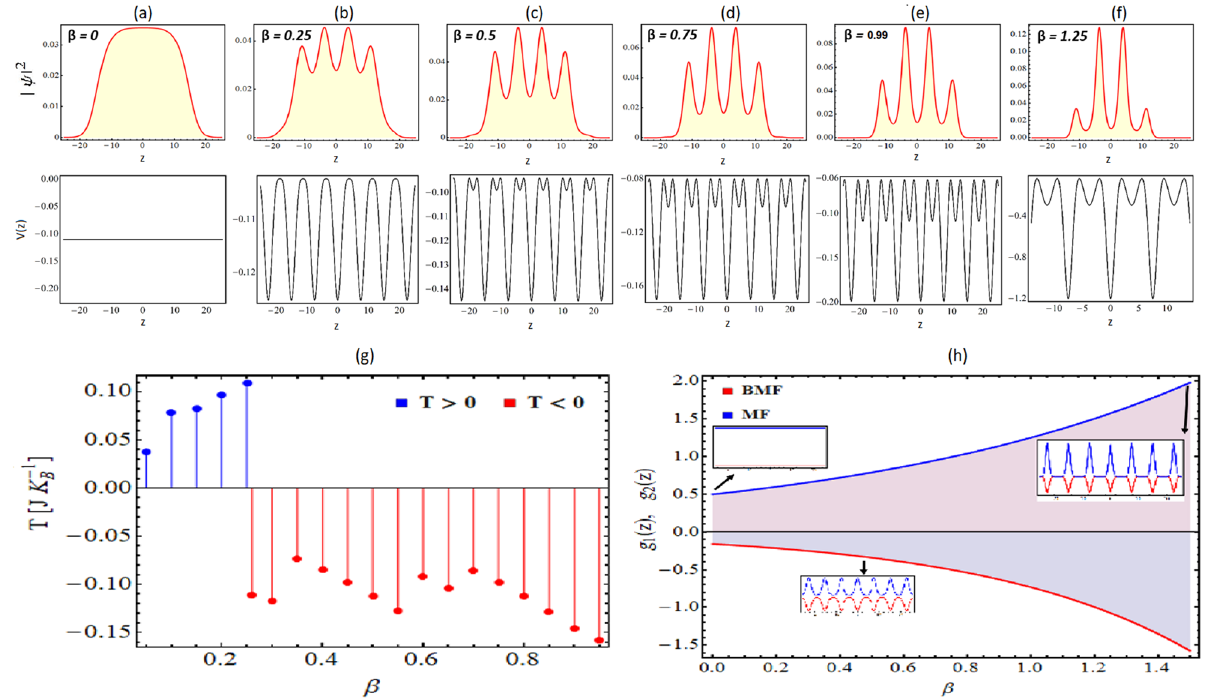
0 and β 0 : ( a ) β 0 (free Figure 1. Condensate density patterns and corresponding BOL trap with M = = = 0.25 , ( c ) β 0.5 , ( d ) β 0.750 , ( e ) β 0.99 , and ( f ) β 1.25 . Each plot of ( a – f ) has two space); ( b ) β = = = = = panels: the upper panel shows the density plot, and the lower panel indicates the corresponding trap profile. 1 ( g ) The figure depicts the estimate of temperature ( JK − B ) with respect to the potential depth of BOL ( β ) and illustrate positive to negative temperature transition. ( h ) The profile of EMF and BMF is plotted with changing 0.84 , G 1 1 , G 2 0.999999 , E 1 , k 2 / 9 . The β . Here, the magnitude of physical parameters: γ 0 = = − = = = − spatial co-ordinate is scaled by the oscillator length. Figures are plotted using MATLAB R2020b (Master License 31349846) and Mathematica version 1.5.1.2021061827, Wolfram Research,